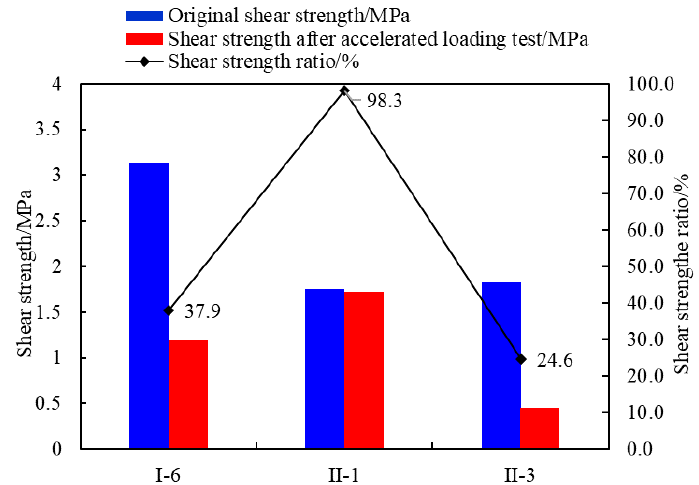
Figure 11. Shear strength and shear strength ratio of the three structures.